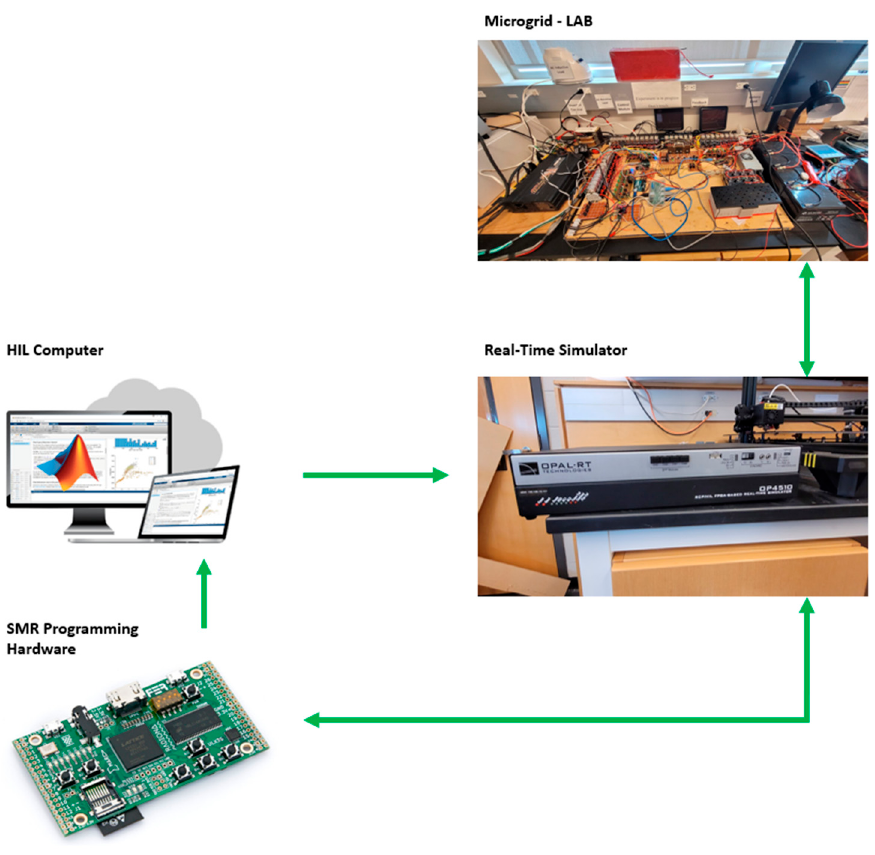
Figure 7. Implementation of SMR-in-the-loop.